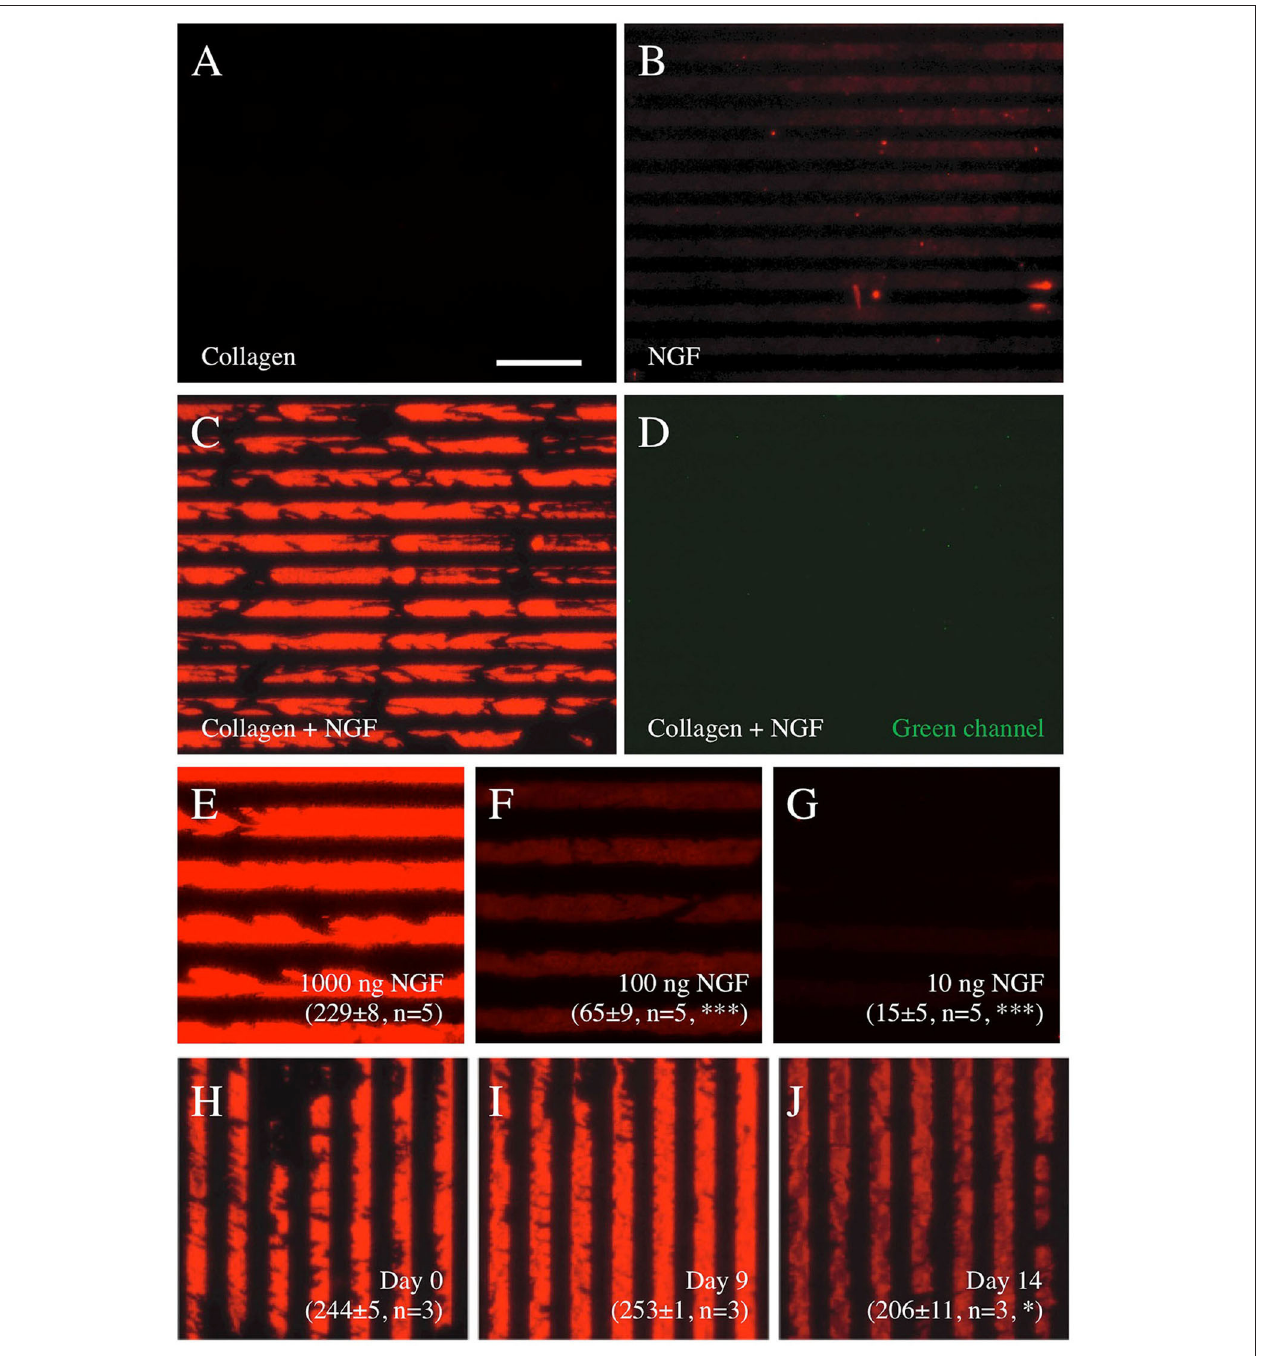
FIGURE 2 | Characterization of nerve growth factor (NGF) µ CP on semipermeable membranes. Printing of collagen alone (A) or NGF alone (B) does not show any positive staining, however, NGF loaded into collagen hydrogel solution shows a typical printing when stained with Alexa-546 anti-NGF antibodies (C) . The staining is specific, as it is not seen in the green channel (D) . A concentration experiment shows that printing with 1,000 ng NGF per stamp (E) gives the best results, while 100 ng (F) and 10 ng (G) NGF do not show good printing. The stability of the prints (1,000 ng NGF loaded into collagen hydrogel solution) in the medium is shown in (H–J) , with strong bands after printing [day 0, (H) ], no change after 9 days in the medium (I) , and a significant decrease after 14 days in the medium (J) . The values in (E–J) give the optical density of the printed pattern from 0 (white) to 255 (black) corrected for the background and measured by computer-assisted imaging. The values are presented as mean ± SEM, with the number of independent experiments ( n ) and statistical differences (* p < 0.05; *** p < 0.001) with ANOVA and Fisher least significant difference (LSD) post hoc test. Scale bar in A = 175 µ m (A–D) , 102 µ m (E–G) , 175 µ m (H–J) .